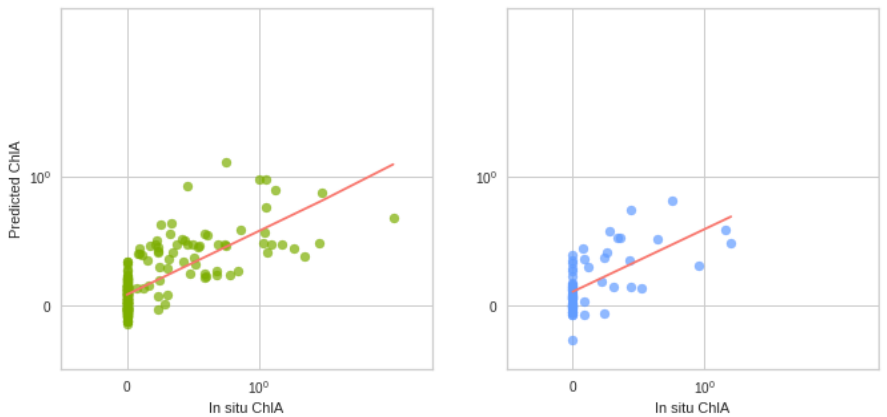
Figure 6. Prediction error plot shows the relationship between in situ and predicted Chlorophyll-a values on train ( left ) and test ( right )